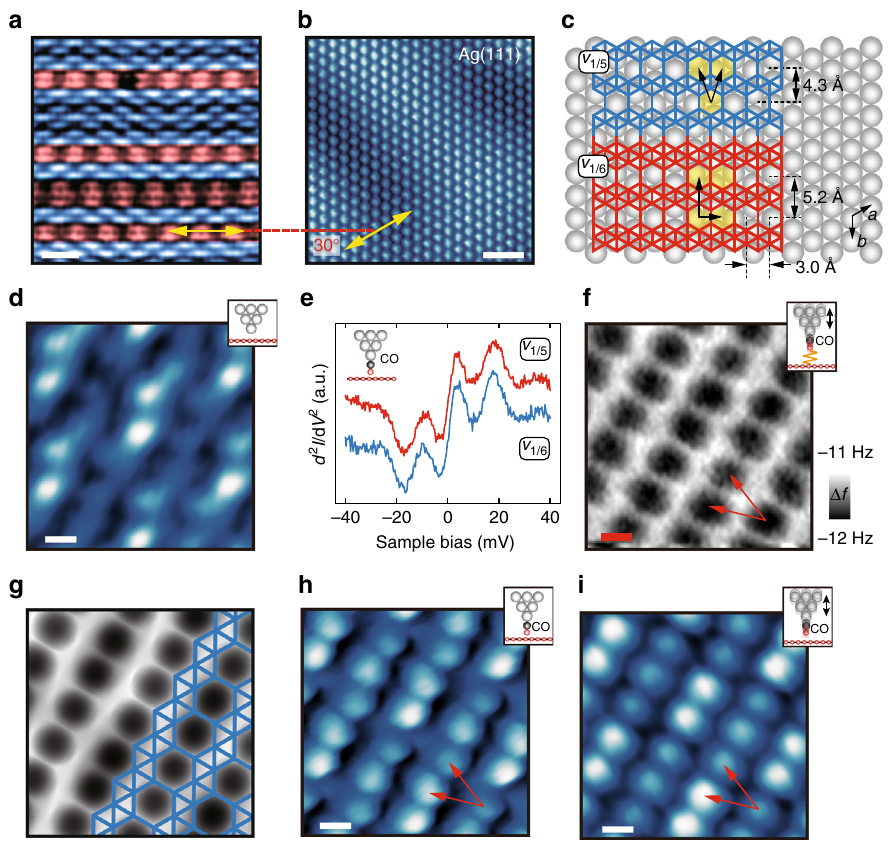
Fig. 1 Imaging v 1/5 phase borophene with bare and functionalized probes. a Bare-tip STM image of intermixed v 1/5 (colored blue) and v 1/6 (colored red) phase borophene. b A neighboring Ag(111) surface, where the angle between the HH rows of borophene (horizontal) in a and the Ag atomic chains is 30° as expected. c Schematic illustration of the rotational orientation of v 1/5 and v 1/6 phase borophene on Ag(111). The arrows mark the unit cells of the HH lattices in each phase. d Bare-tip STM image of v 1/5 phase borophene. e Inelastic electron tunneling spectroscopy on borophene with a CO-functionalized tip. f CO-AFM image of v 1/5 phase borophene. g Simulated CO-AFM image of v 1/5 phase borophene with overlaid atomic structure. h CO-STM and i dynamic CO-STM image of v 1/5 phase borophene. The red arrows in f , h , and i denote the unit cells corresponding to the HH lattice. V s = − 10 mV in a , 20 mV in b , 100 mV in d , − 7 mV in h , and 15 mV in i . Scale bars, 2 nm in a , 1 nm in b , 2 Å in d , f , h ,